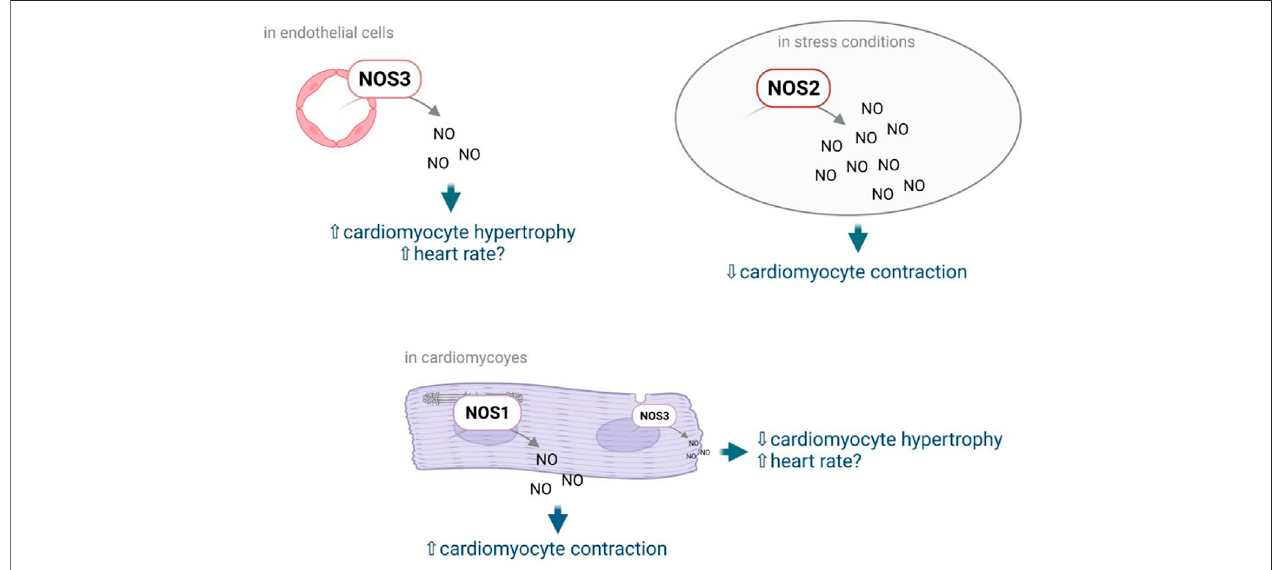
FIGURE2| NOeffectsoncardiomyocytesdependontheNOSbywhichithasbeenproduced,andthecellsinwhichithasbeenproduced. NotablyNOproduced by NOS3 in ECs may promote cardiomyocyte hypertrophy while NO produced by NOS3 in cardiomyocytes was shown to prevent cardiomyocyte hypertrophy. NO produced by NOS3 was also shown to increase heart rate; however the cell type in which NO is produced is not known. NO produced by NOS1 in cardiomyocytes promotes cardiomyocyte contractility while NO produced by NOS2 upon stress decreases cardiomyocyte contractility.